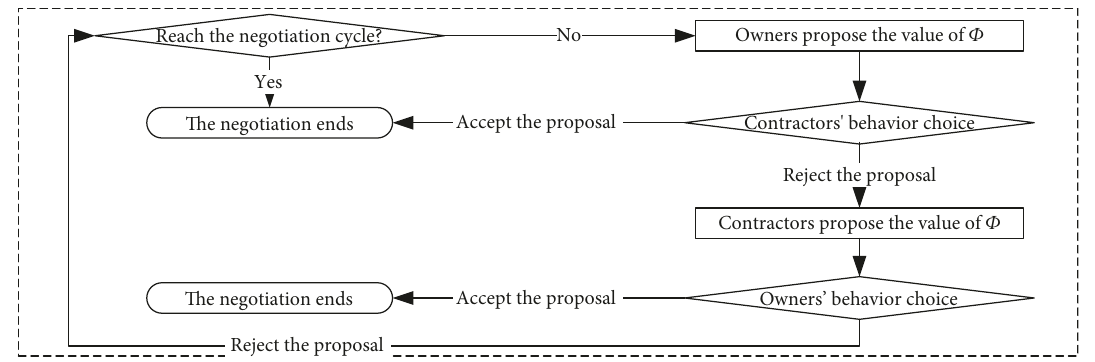
Figure 2: Negotiation processes between the owner and